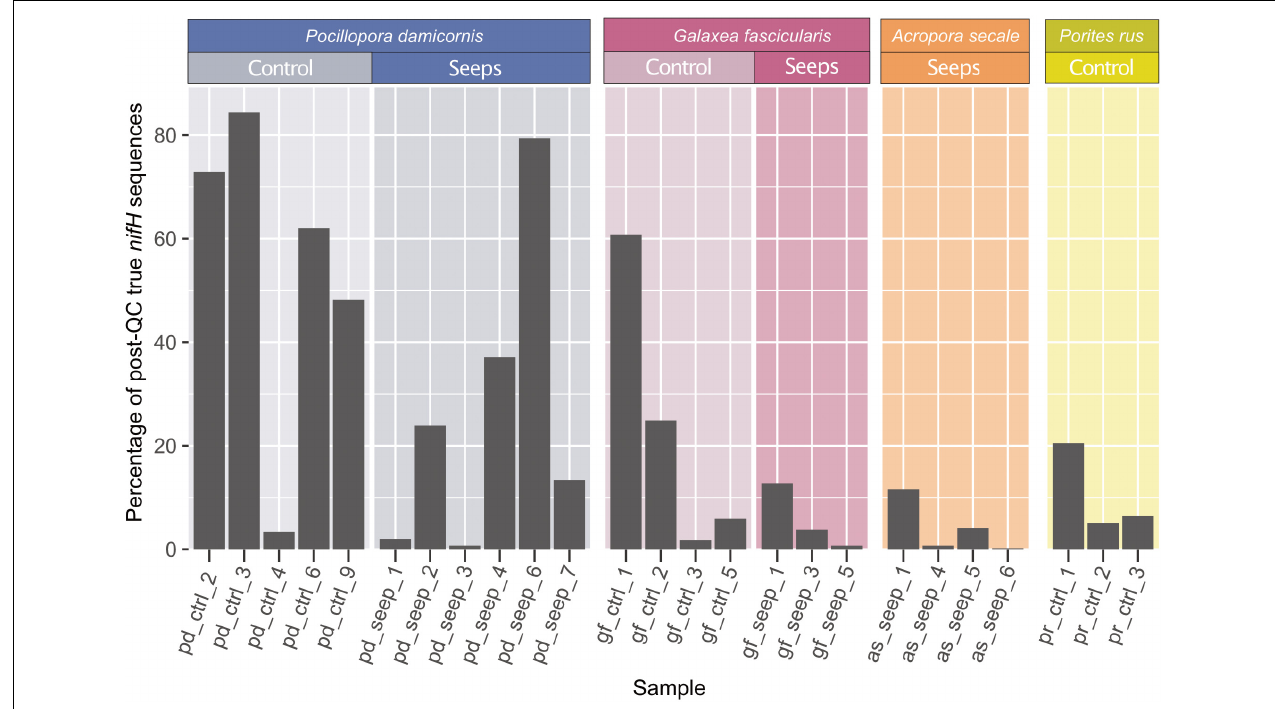
FIGURE 1 | nifH sequencing overview. Percentage of retained sequences after quality control and minimum entropy decomposition (MED) that were annotated as true nitrogenase genes belonging to nifH Clusters I–III (black) relative to the total amount of post-QC retained sequences. Only the 25 samples with ≥ 100 true nifH sequences are shown and were kept for all subsequent